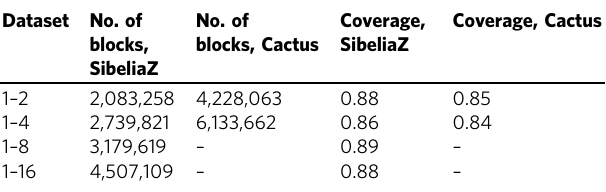
Table 2 Number of blocks and coverage by the multiple whole-genome alignments computed by SibeliaZ and Cactus from the mice datasets.